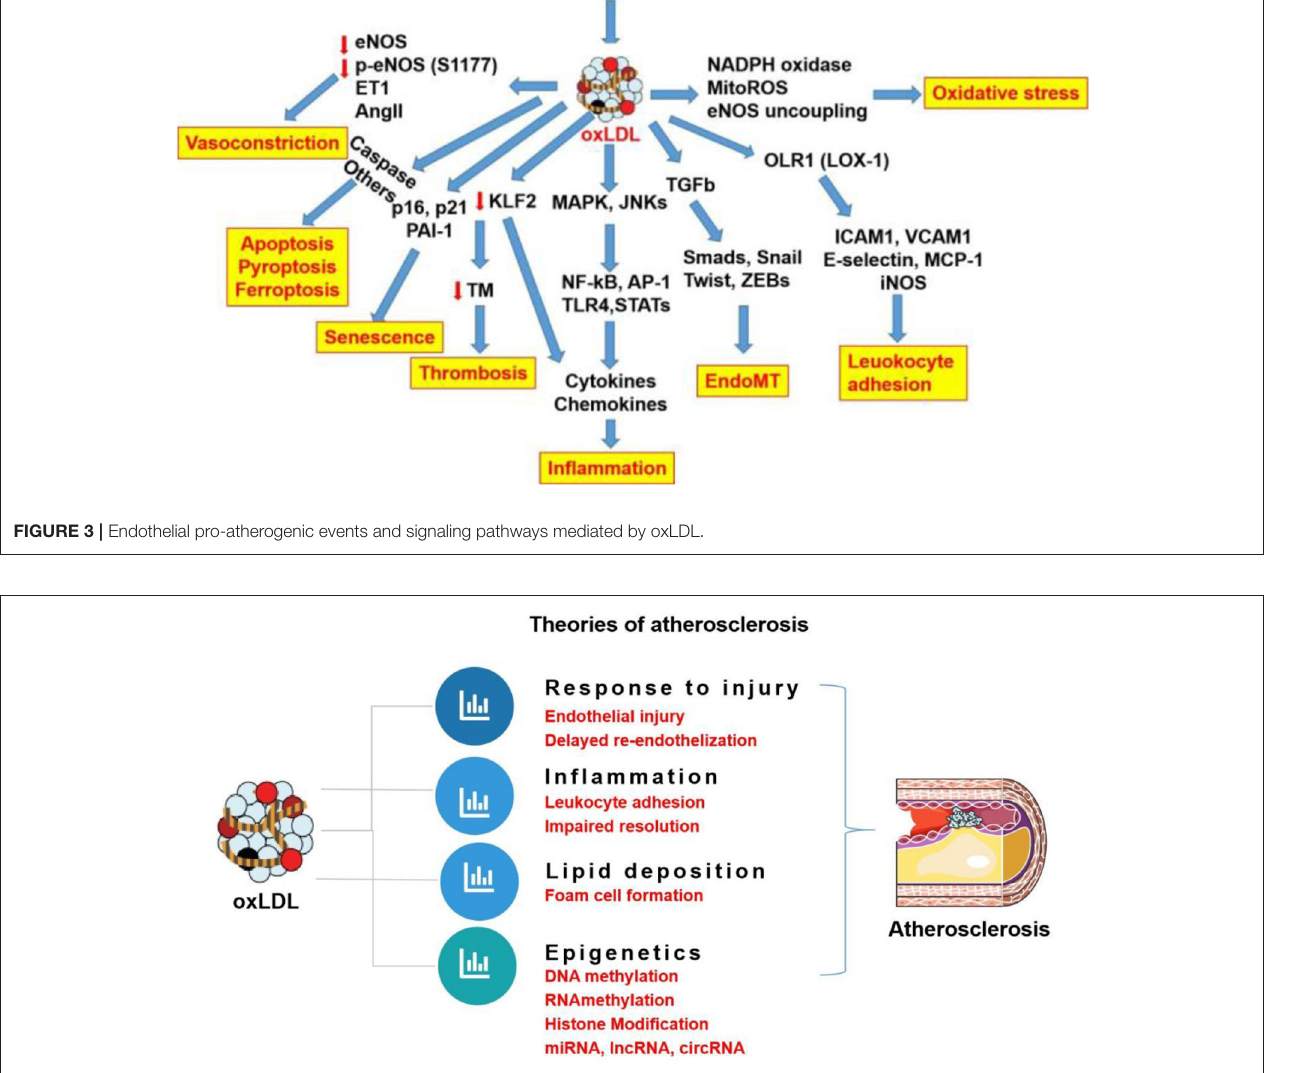
FIGURE 4 | Pivotal role of oxLDL in main theories of